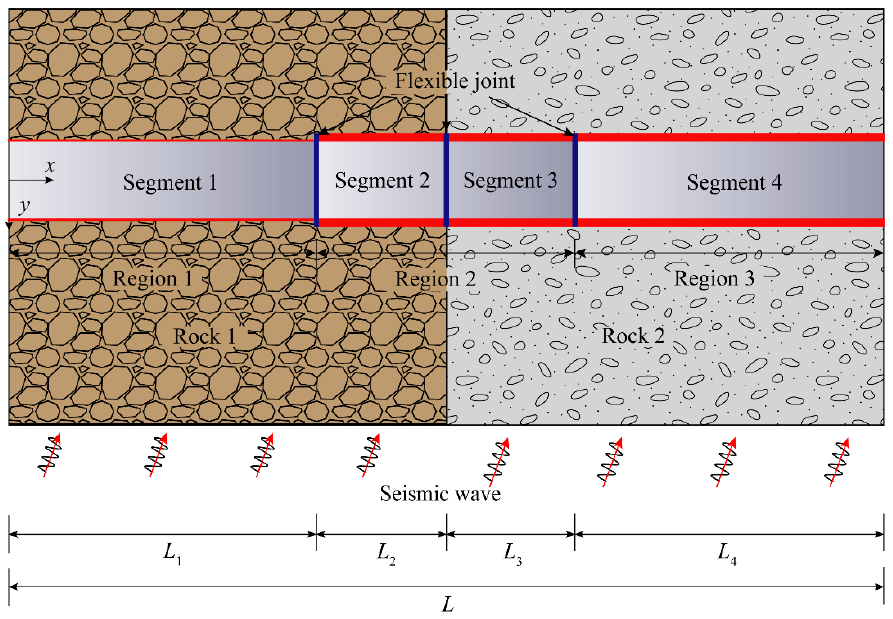
Figure 1. Longitudinal profile of the tunnel.